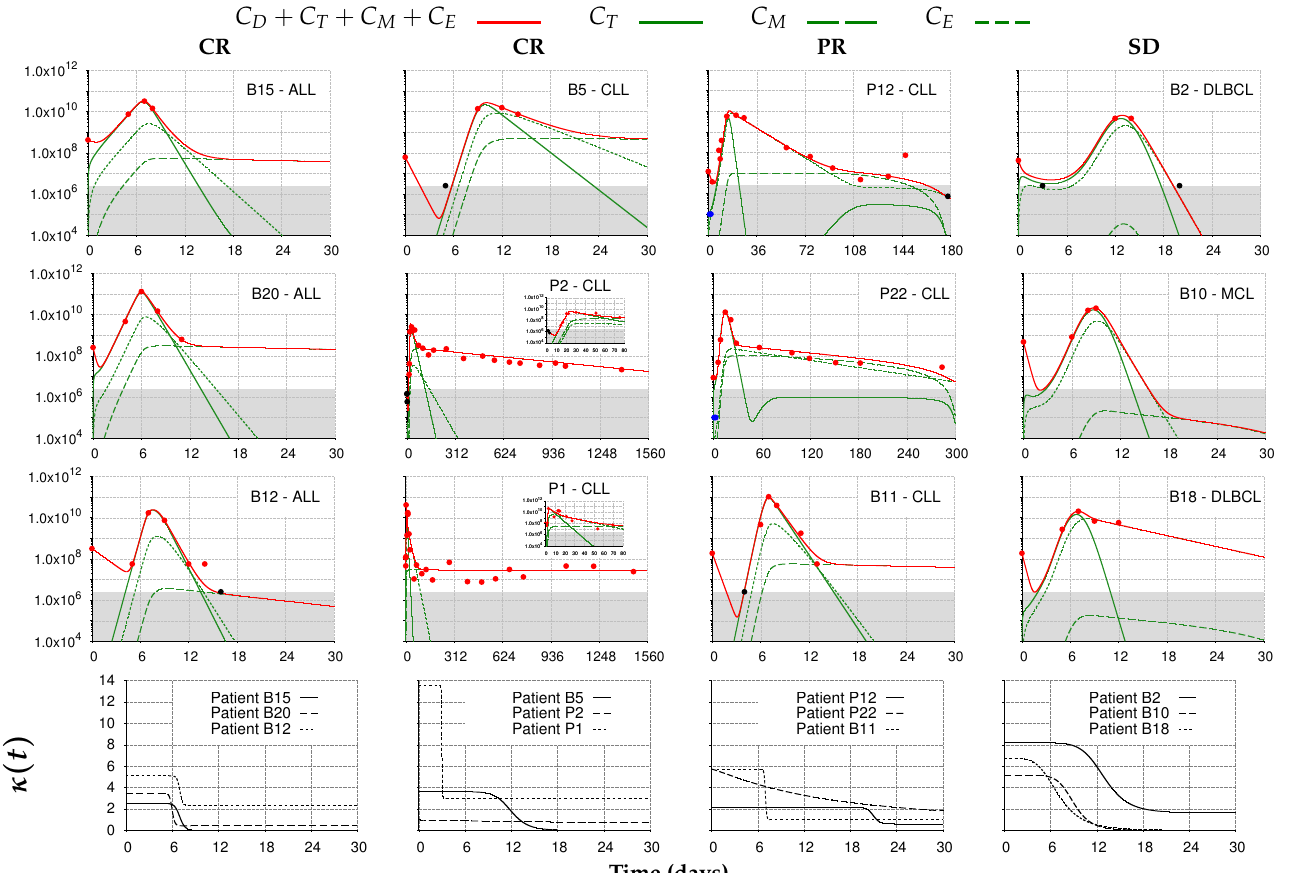
Figure 4. Model simulations fitted to the experimental data ( • ) from [37,38]. Each column corresponds to the dynamics of the total CAR-T cell population ( ) for different therapy responses at the last follow-up (interval from infusion to the last follow-up in days) (CR—complete response, PR—partial response, and SD—stable disease) and different patients. The total CAR-T cell population is divided into effector ( C T ), memory ( C M ), and exhausted ( C E ) phenotypes, shown in continuous, dashed, and dotted green, respectively. The gray region represents the undetectable level. Data points ( • ) may assume any value in this region, but some ( • ) were not used for calibration and error calculation of the model due to their greater uncertainty. The bottom row presents the time-dependent expansion rate function ( κ ( t ) ) for each